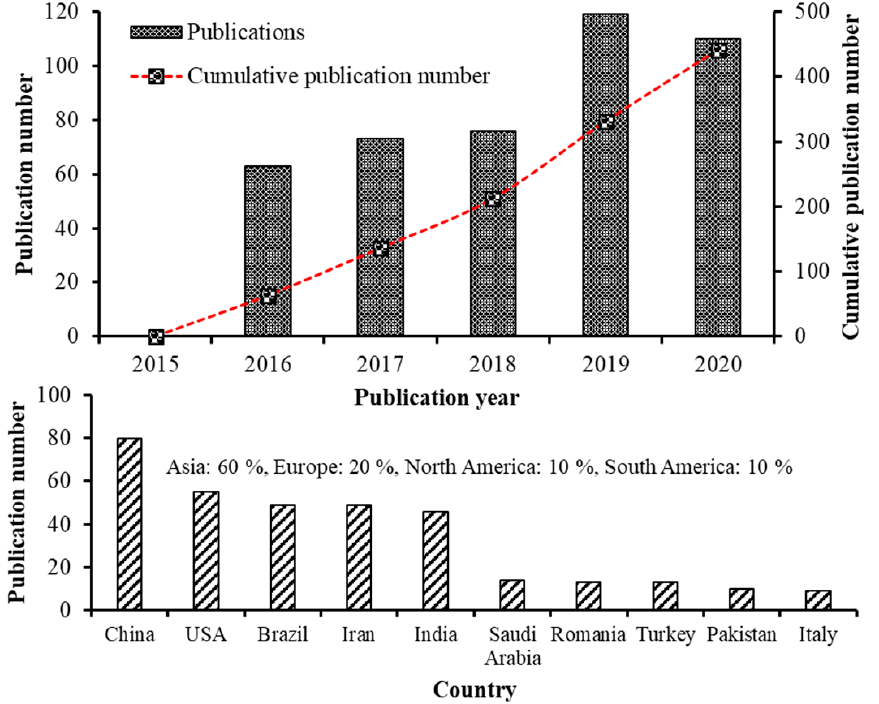
Figure 1. Research on carotenoid nanoemulsions over the last 5 years. The number of publications and global distribution. Source: Web of Science ™ .